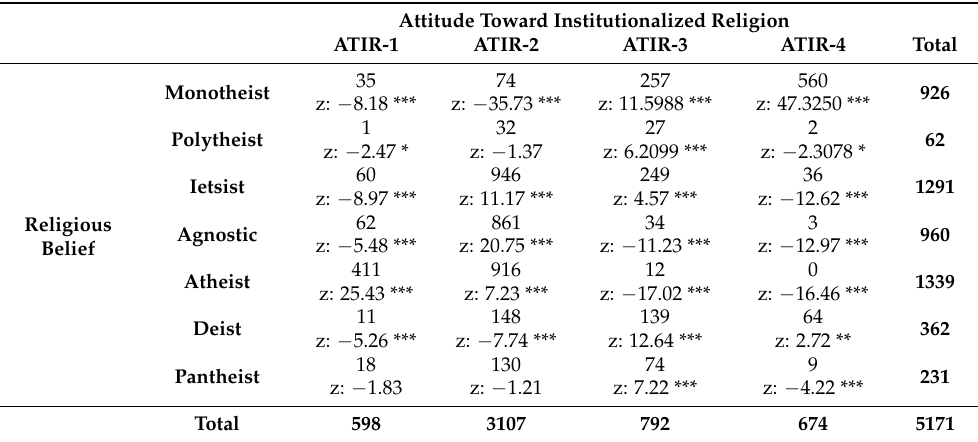
Table 3. Relationship between the attitude toward institutionalized religion (ATIR) and religious belief. Attitude Toward Institutionalized Religion